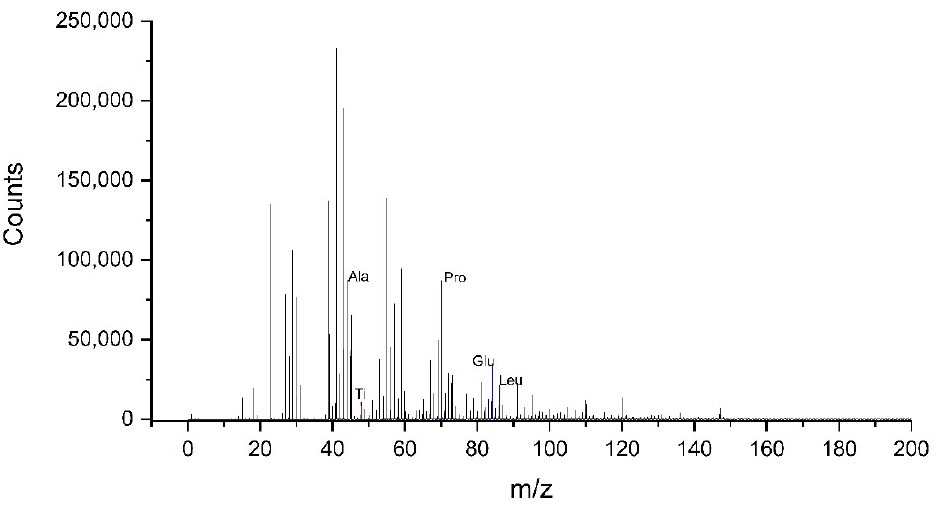
Figure 1. Positive ion time of flight secondary ion mass spectrometry (ToF-SIMS) spectra of the TiAlV surface coated with a solution with 10 µg/mL of HSA concentration.